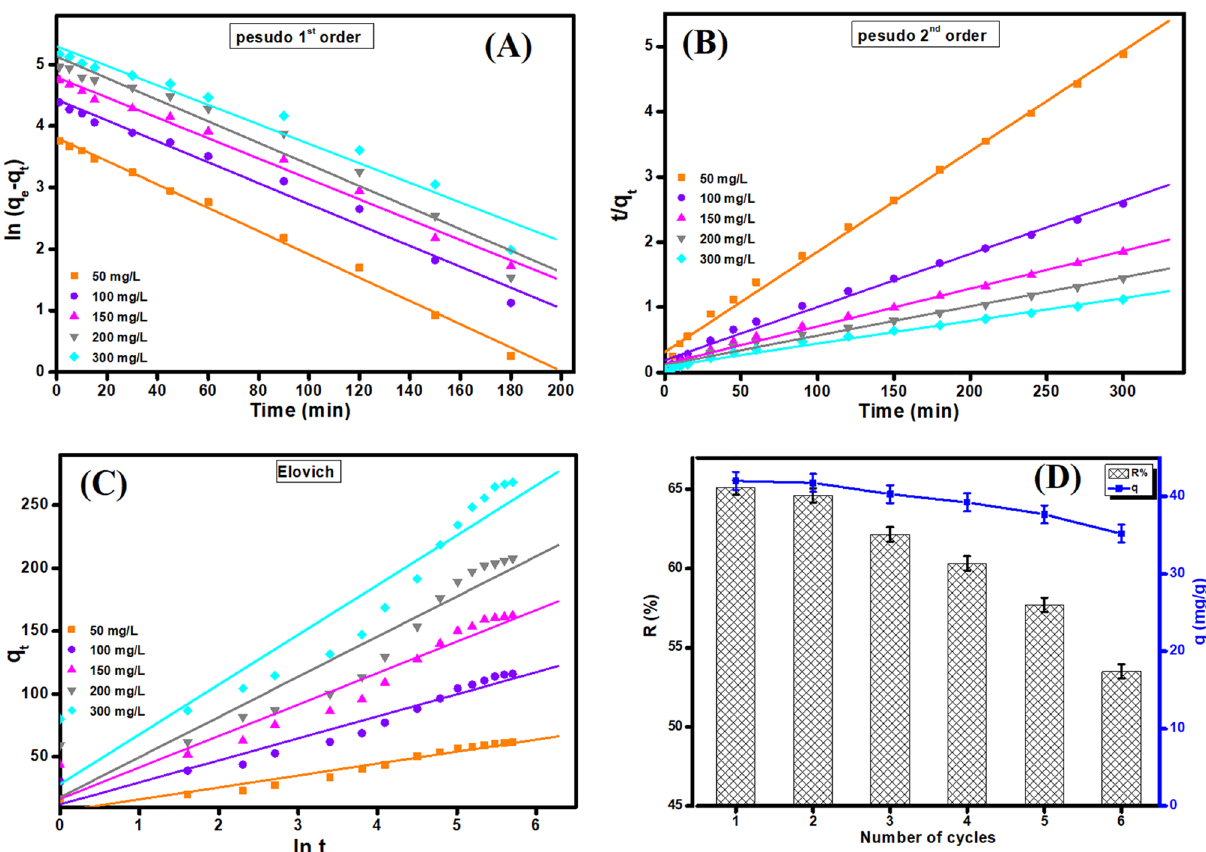
Figure 9. ( A ) Pseudo-first-order, ( B ) Pseudo–second-order and ( C ) Elovich kinetic models for adsorption of TC onto MIL-125(Ti)/MIL-53(Fe)/CNT@Alg composite microbeads. ( D ) Regeneration and reusability of MIL- 125(Ti)/MIL-53(Fe)/CNT@Alg composite